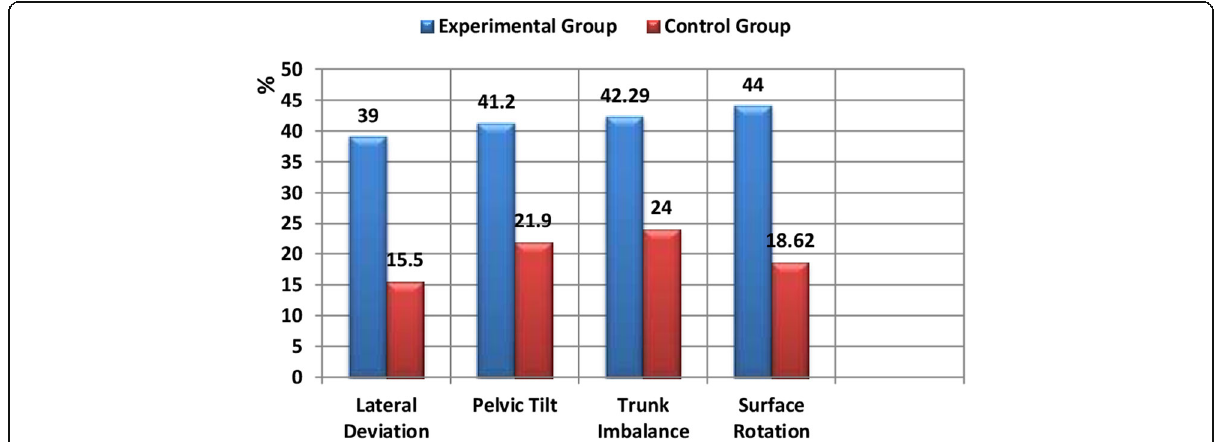
Fig. 5 Percentage (%) of change between pre- and post-treatment values of spinal geometry for the experimental and control